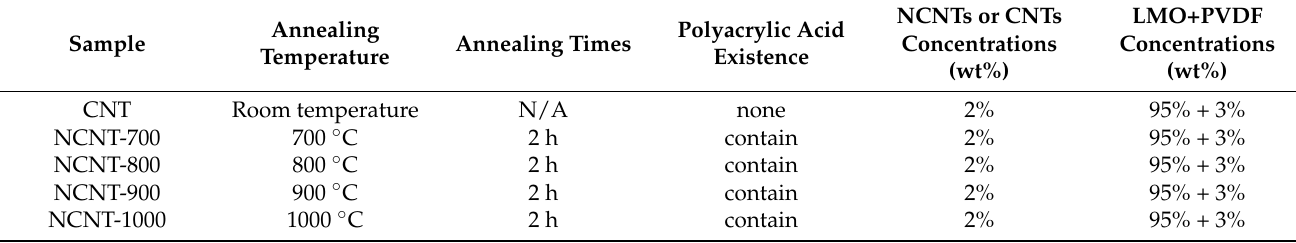
Table 1. Details of CNTs and NCNTs samples